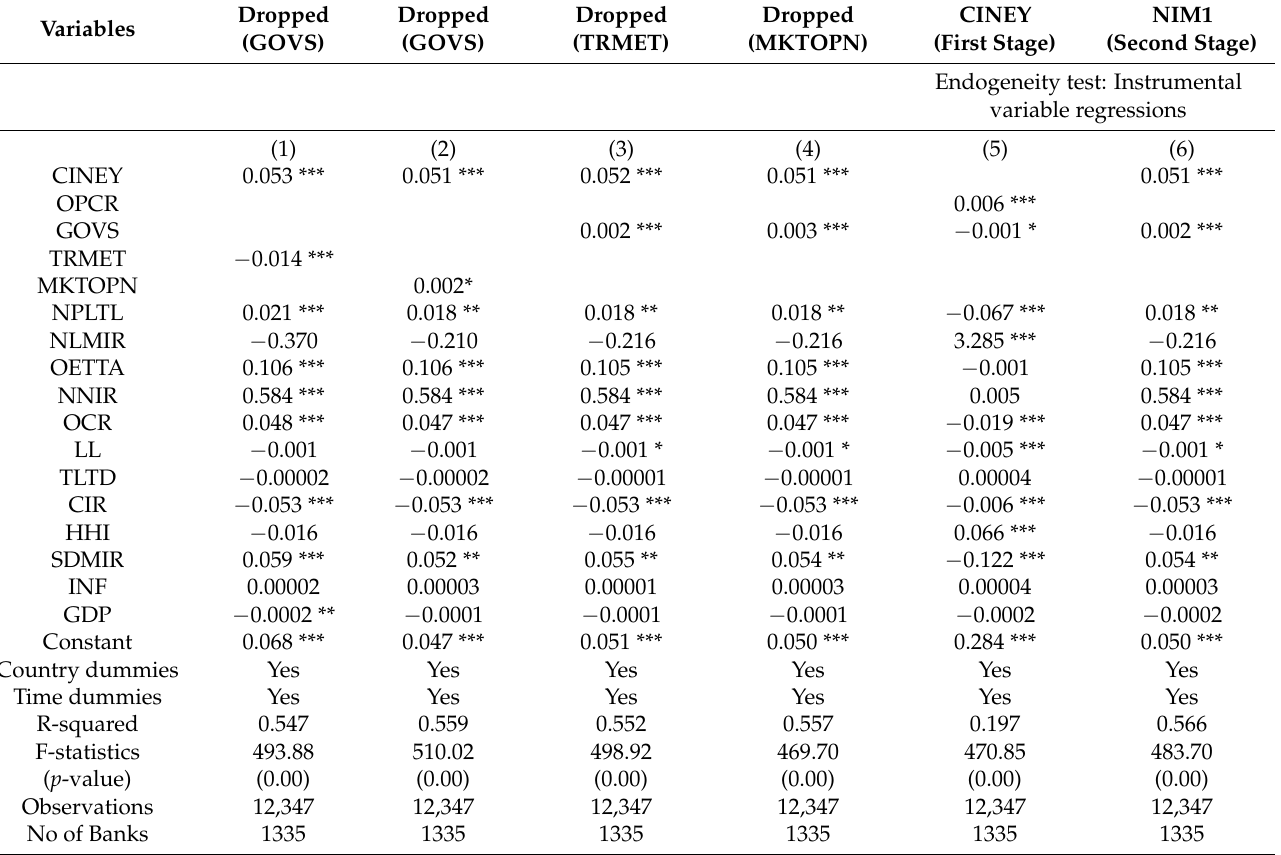
Table 7. Dropping the contributing variables and